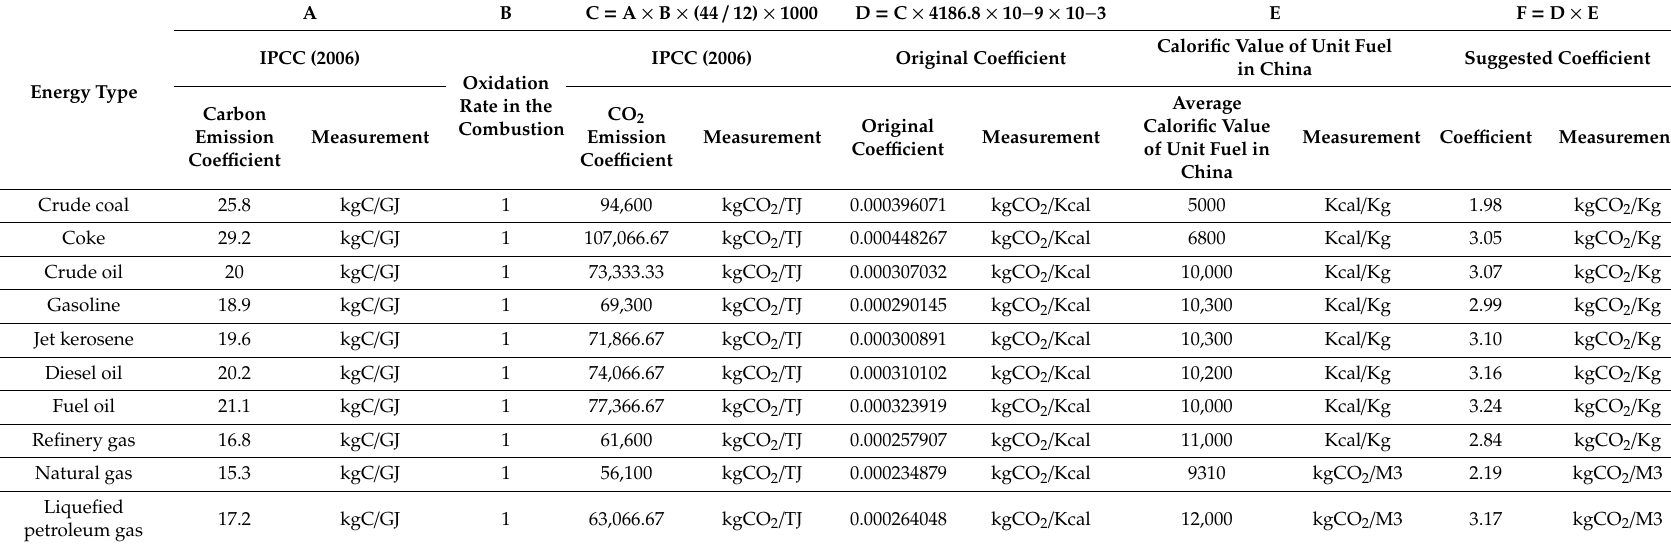
Table 3. Coe ffi cient of CO 2 emissions in